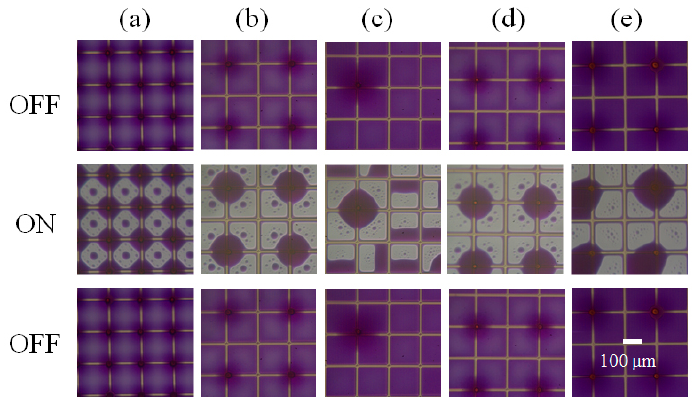
Figure 3. Graph shows the OFF, ON, and OFF states from up to bottom with applied voltage of 30 V. (1) Effect of spacer densities (number of spacers: number of pixels, ( a ) 1:1, ( b ) 1:4, and ( c ) 1:16 on oil motion and gathering behavior with the spacer height of 60 μ m. (2) Effect of spacer heights (( b ) 60, ( d ) 40, and ( e ) 20 μ m) on oil motion and gathering behavior with the spacer density of 1:4. Spacer height was tested with the best density of 1:4. The pixels with spacer height of 60 μ m (Figure 3b and Figure S1b) and 40 μ m (Figure 3d and Figure S1d) achieved a large oil droplet around